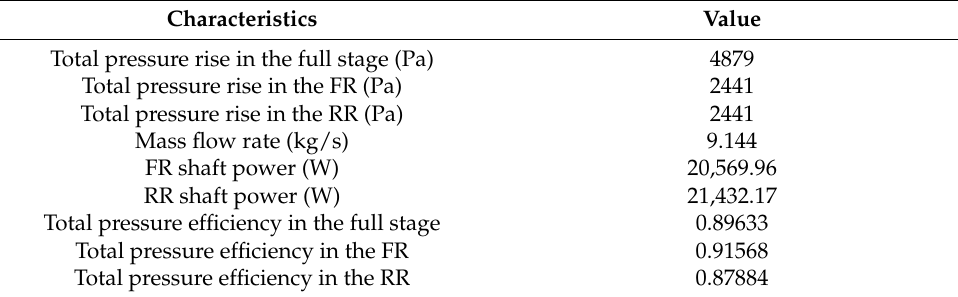
Table 5. CFD results of the baseline CRF at the design